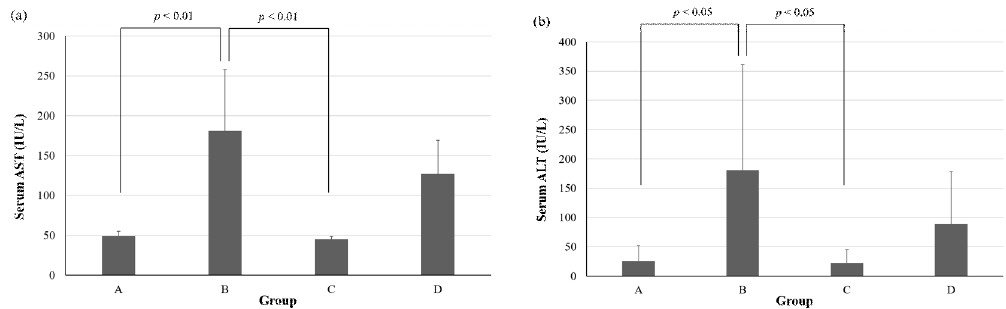
Figure 4. The di ff erence in the serum the aspartate transaminase (AST) ( a ) and alanine aminotransferase (ALT) ( b ) levels of mice with the simultaneous administration of ethanol with or without live SN13T cells. The values are indicated as the mean ± SD. Statistical analysis was performed using the Tukey–Kramer multiple comparisons test. The experimental content of each group is the same as that in Figure 3.